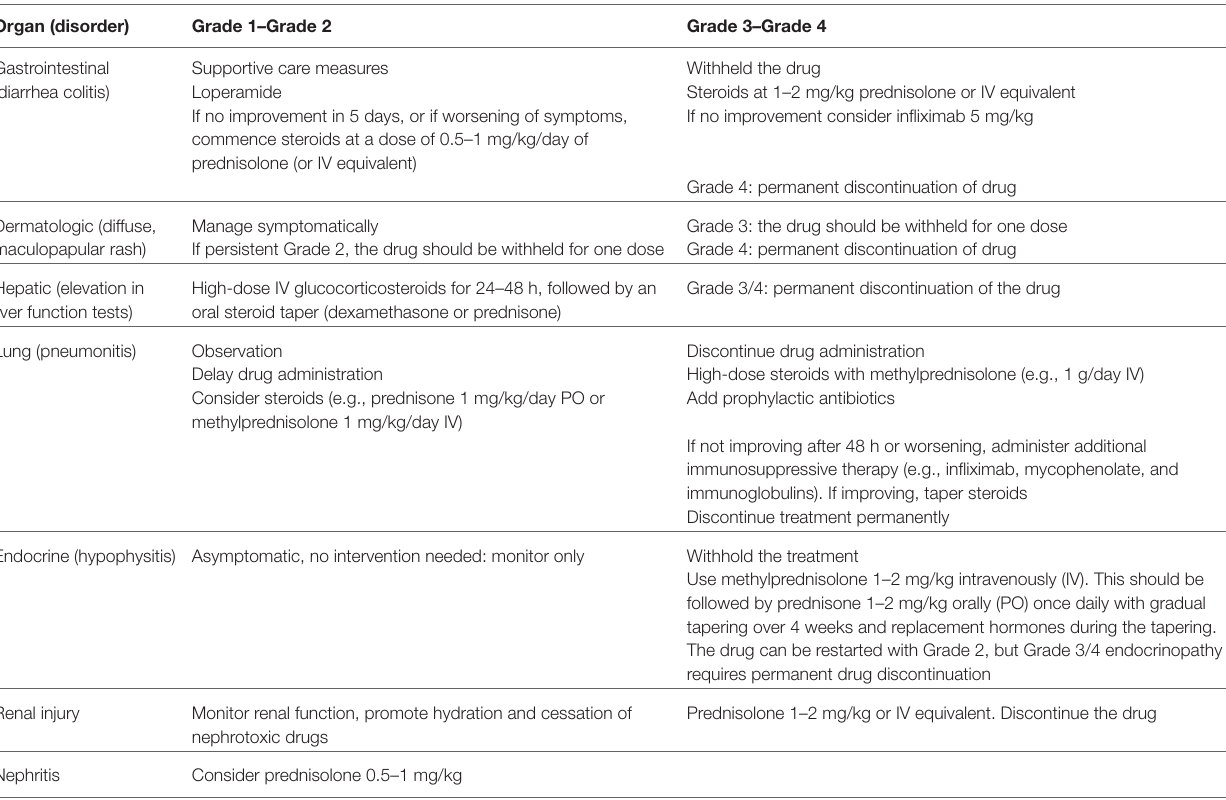
TABLe 3 | Management of selected immune-related adverse